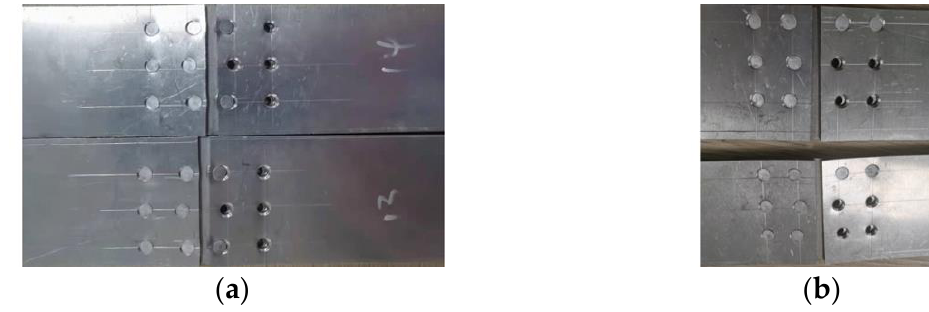
Figure 19. Part of the connector rivets fall off: ( a ) increase the rivet row spacing at both ends of the inner side; ( b ) decrease the rivet row spacing at both ends of the inner side.